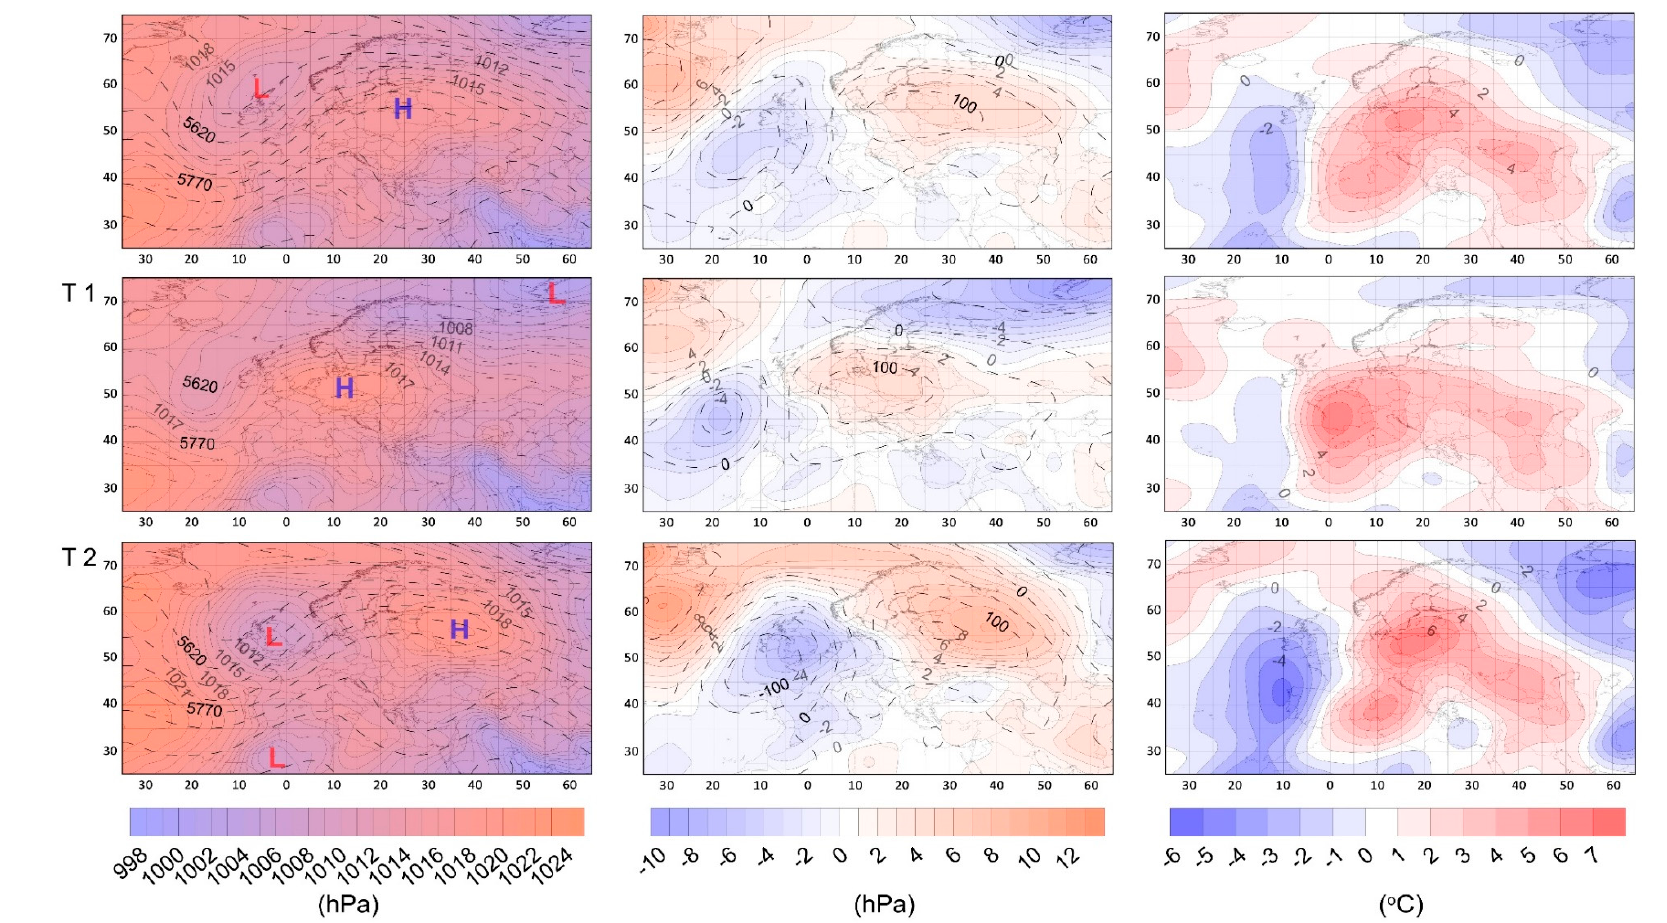
Figure 9. Mean SLP (in hPa) (colour scale) and z500 hPa (in gpm) (dotted line) (left column); SLP (in hPa) (colour scale) and z500 hPa anomalies (in m) (dotted line) (middle column); and anomalies of T850 (in °C) (right column) for average conditions and for situations 1 (T1) and 2 (T2) in June 2019.